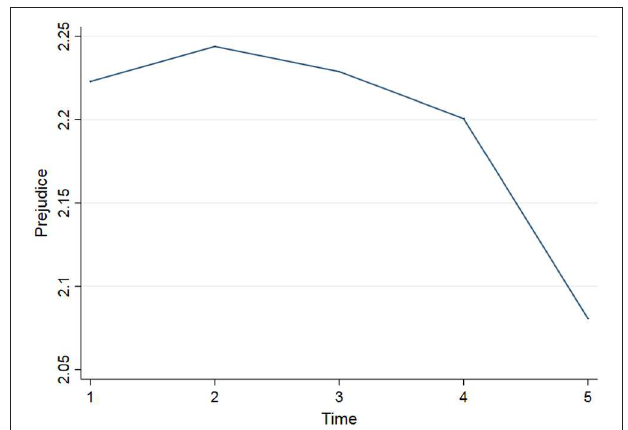
FIGURE 1 | Average levels of prejudice